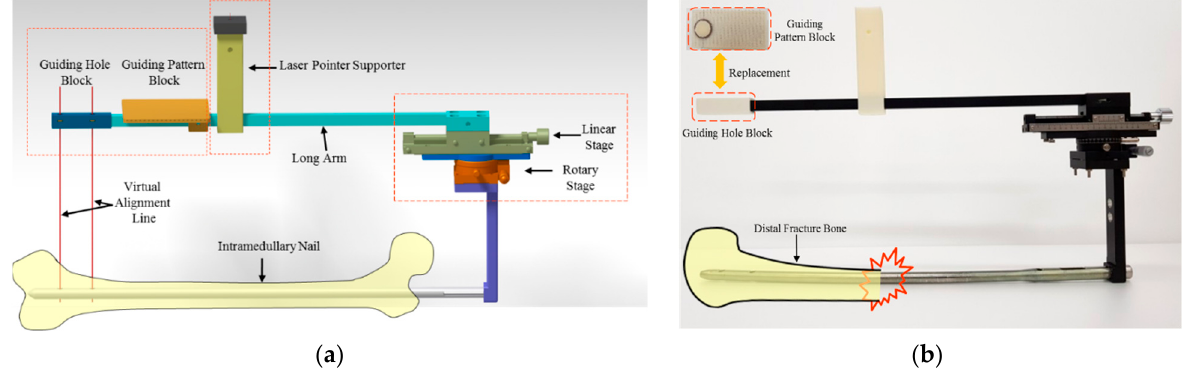
Figure 3. Proposed fine adjustment device. ( a ) 3D model ( b ) Fabricated prototype.